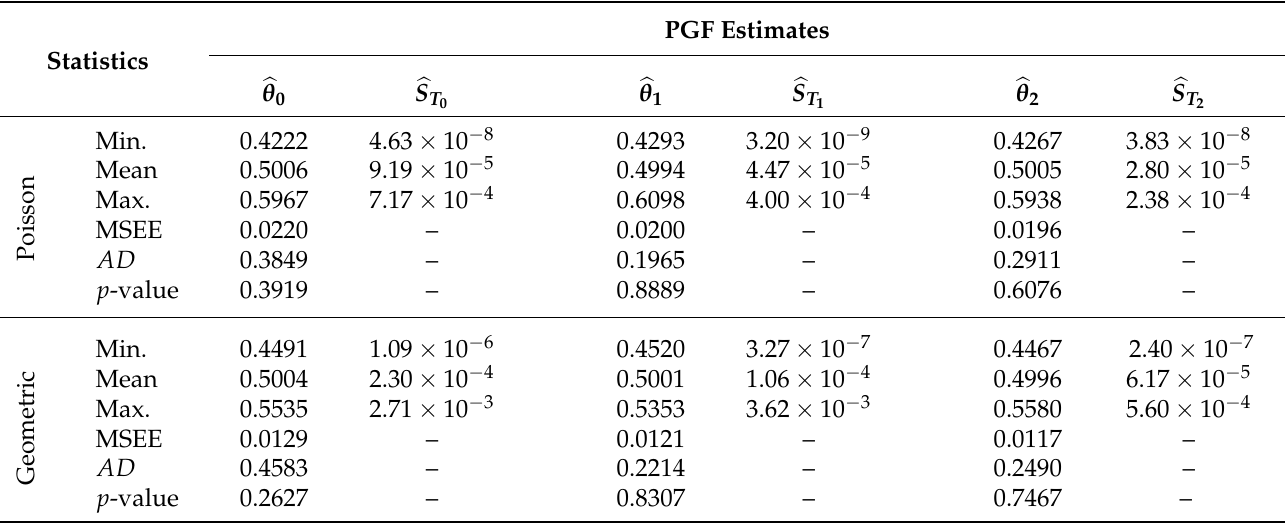
Table 2. Estimated parameters’ values of IID series ( ε t ) series with Poisson and geometric distribution. ( True parameter value is θ =